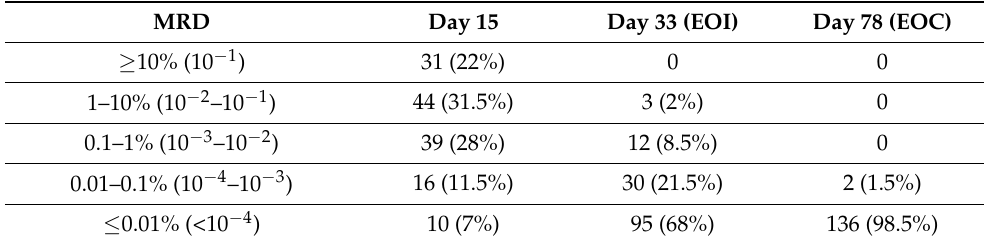
Table 5. MRD levels in bone marrow on day 15, day 33, and day